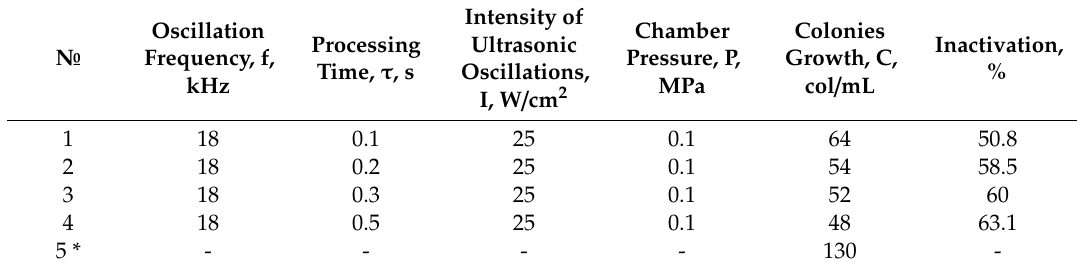
Table 1. Results of experimental studies of the e ff ect of ultrasound alone on microorganism inactivation.